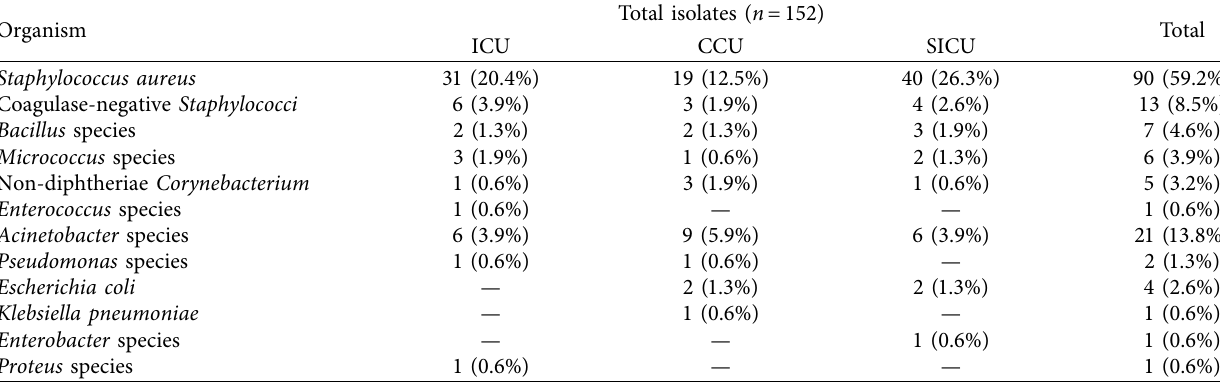
Table 1: Frequency of bacterial isolates colonized on objects of intensive care units.